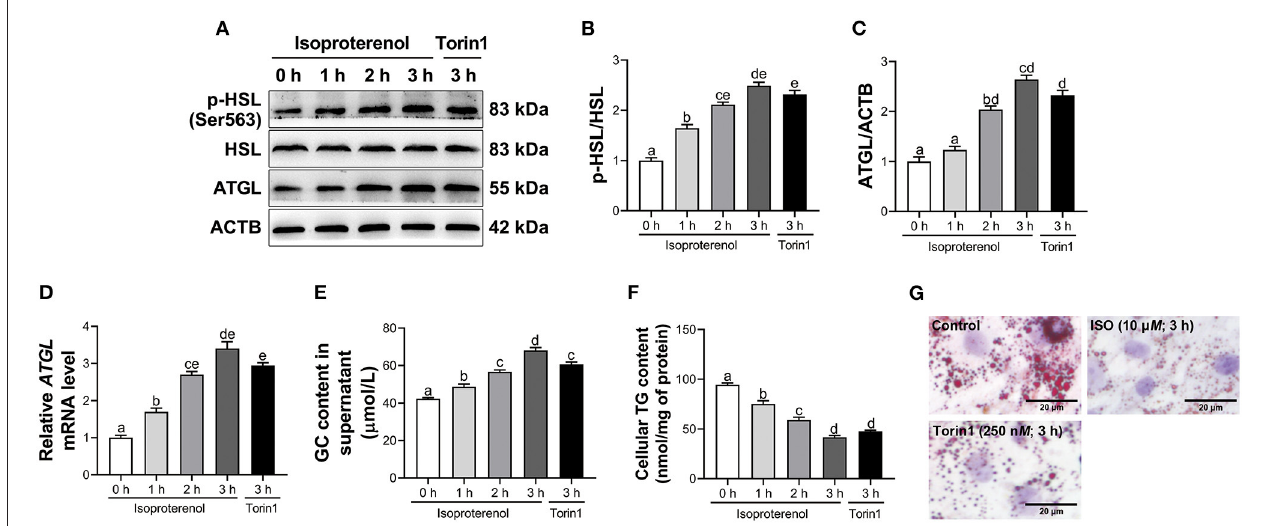
FIGURE 3 | Isoproterenol (ISO) and Torin1 treatment induce lipolysis in calf adipocytes. Calf adipocytes were stimulated with 10 µ M ISO for 0, 1, 2, or 3h, or treated with 250 n M Torin1 for 3h. (A) Western blot analysis of phosphorylated hormone sensitive lipase (p-HSL), HSL and adipose triacylglycerol lipase (ATGL) in calf adipocytes. Representative blots are shown. (B,C) Quantification of ratio of p-HSL/HSL and protein abundance of ATGL, respectively. (D) Relative mRNA abundance of ATGL in calf adipocytes. (E) The content of glycerol (GC) in the supernatant of calf adipocytes. (F) The triglyceride (TG) content in calf adipocytes. (G) Oil Red O staining. Scale bar = 20 µ m. Data were analyzed using one-way ANOVA with Tukey’s tests for data meeting homogeneity of variance or with Tamhane’s T2 analysis for data of heteroscedasticity and expressed as mean ± SEM. The same letter (a-e) indicates no significant difference ( P > 0.05), whereas different letters indicate a significant difference ( P <